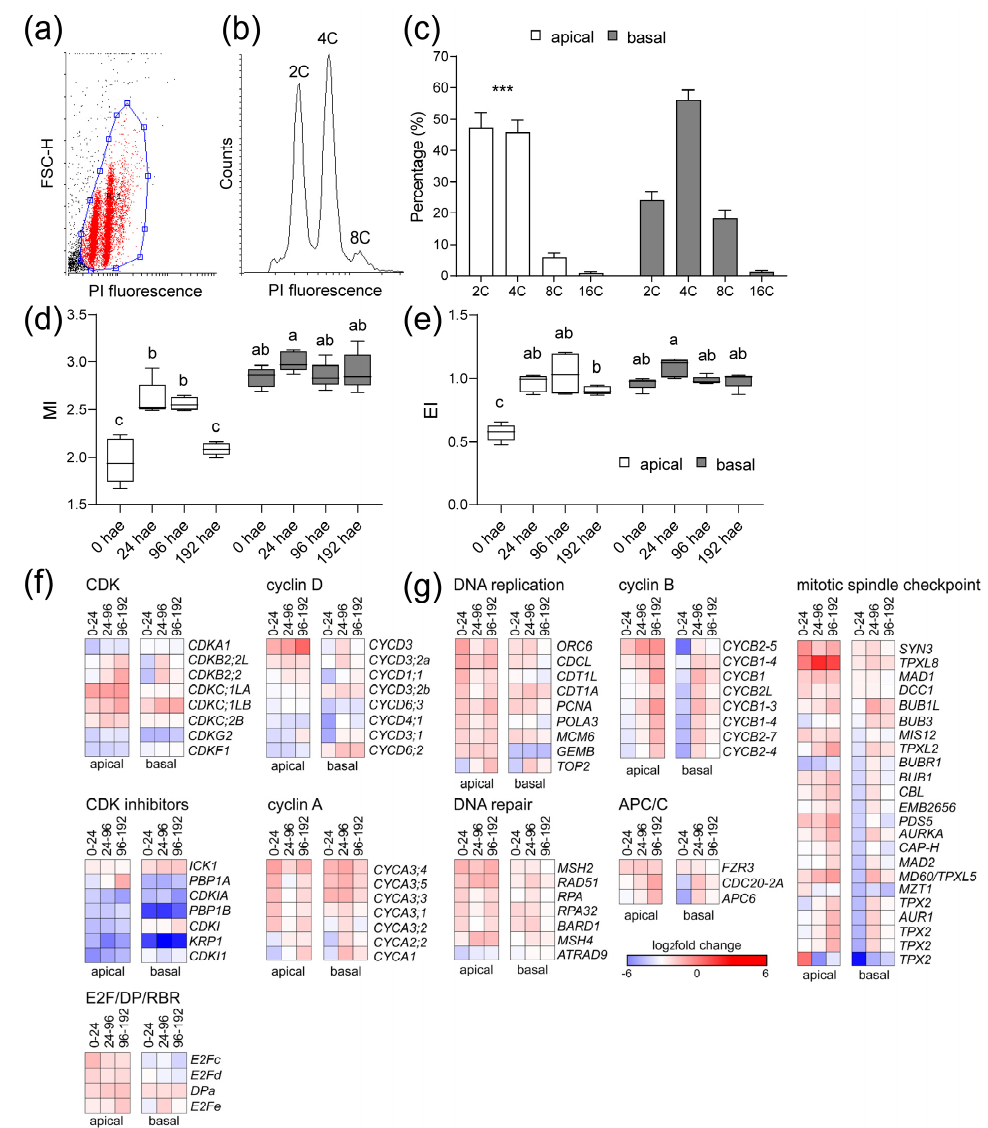
Figure 6. Regulation of the cell cycle during de novo organ formation. ( a – e ) Ploidy analysis by flow cytometry. ( a ) Bivariate scatter plot of forward scatter height (FSC-H) versus propidium iodide (PI) fluorescence. ( b ) Histogram of the DNA content of a representative sample from the apical region at 0 hae. ( c ) Proportion of nuclei with different DNA content in the apical (white bars) or the basal (black bars) region at 0 hae; asterisks indicate significant differences ( p value < 0.001) between the regions studied. ( d – e ) Mitotic index (MI; ( d )) and endoreduplication index (EI; ( e )) over time; letters in d and e indicate significant differences (Fisher’s least significant difference (LSD); p value < 0.001) between samples. ( f , g ) Expression profile of DEG involved in cell cycle regulation. A set of 172 putative core cell cycle genes involved in the different phase transitions were studied (Table S5). Blue/white/red in f and g indicate normalized cpm values in each row, where red indicates the highest abundance of transcripts. Gene annotations are found in Table S5.